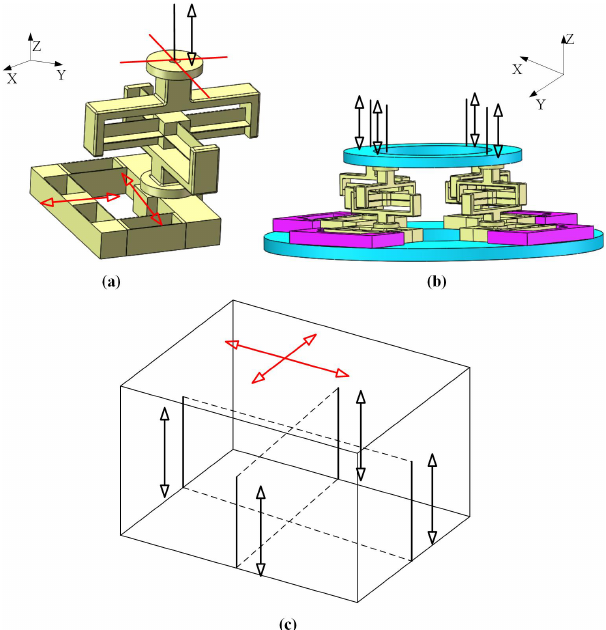
Figure 7. (a) The freedom lines and the constraint lines of the P i P j U ij compliant branch. (b) The constraint lines of the 4 − P i P j U ij redundant actuated compliant parallel mechanism. (c) The freedom lines and the constraint lines of the 4 − P i P j U ij redundant actuated compliant parallel